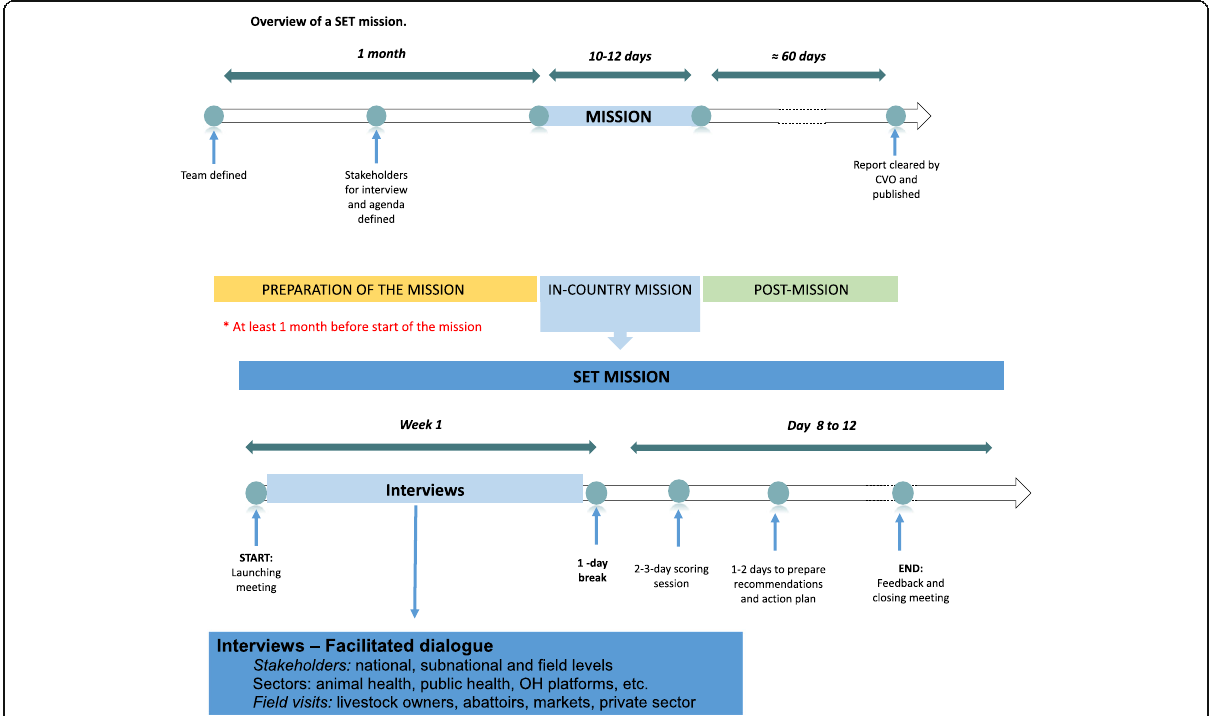
Fig. 2 Overview of a SET mission. After at least 1 month of preparation, the in-country SET mission is conducted for 10 – 12 days. After a launching meeting with key decision-makers, the first week of the mission is dedicated to interviews with all relevant stakeholders. The second week of the mission is dedicated to scoring all 90 indicators of SET and 32 indicators of the SET Biothreat Detection Module (if used), and the development of recommendations and a first draft of the action plan for improvement of the country ’ s animal disease surveillance system. The second week ends with a closing meeting presenting the main results and recommendations to key decision-makers. The SET report is drafted, finalized and cleared for publication by the country ’ s Chief veterinary officer approximately 60 days after the in-country